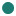
Caffeine-treated rats recovered their righting reflex at a significantly higher isoflurane concentration than did the same rats when treated with saline.A, A group of 16 adult female rats were anesthetized and then injected with either saline (●) or caffeine (●) (37.5 mg/ kg) on two different days. The protocol for determining the isoflurane concentration where rats recovered their righting reflex is described in the Methods section. The order of caffeine or saline was randomized, with 8 rats receiving caffeine on the first anesthesia session and 8 rats receiving saline. The caffeine-treated rats recovered their righting reflex at 0.86 ± 0.14% isoflurane (mean ± SD), while the saline-treated rats recovered their righting reflex at 0.42 ± 0.19% isoflurane, p < 0.0001, n = 16 (paired T-test). B, plots the isoflurane concentrations recorded at RORR for all 16 rats. Symbols in green represent the isoflurane levels recorded at RORR for the saline session, while those in red represent the caffeine session.